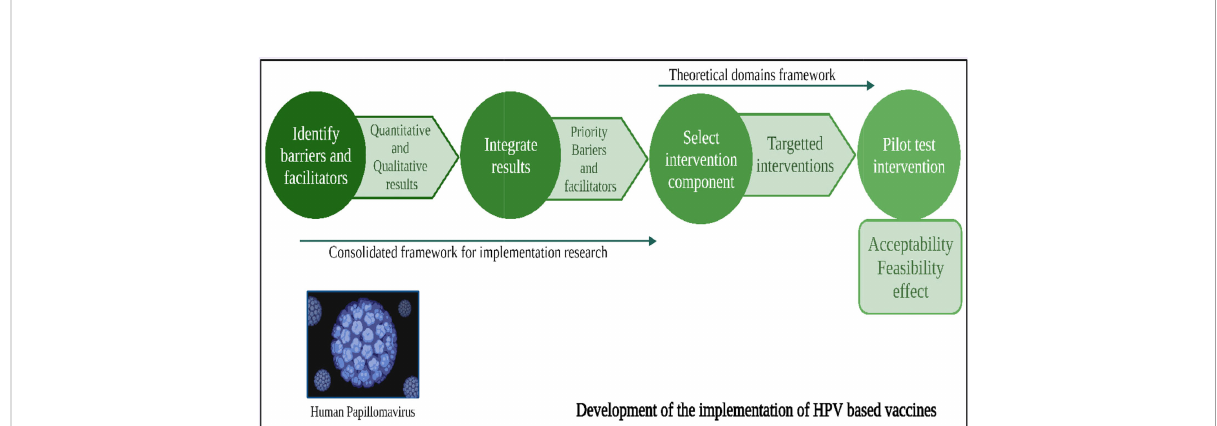
FIGURE 3 Graphical model showing the development of HPV vaccines over the years to combat related